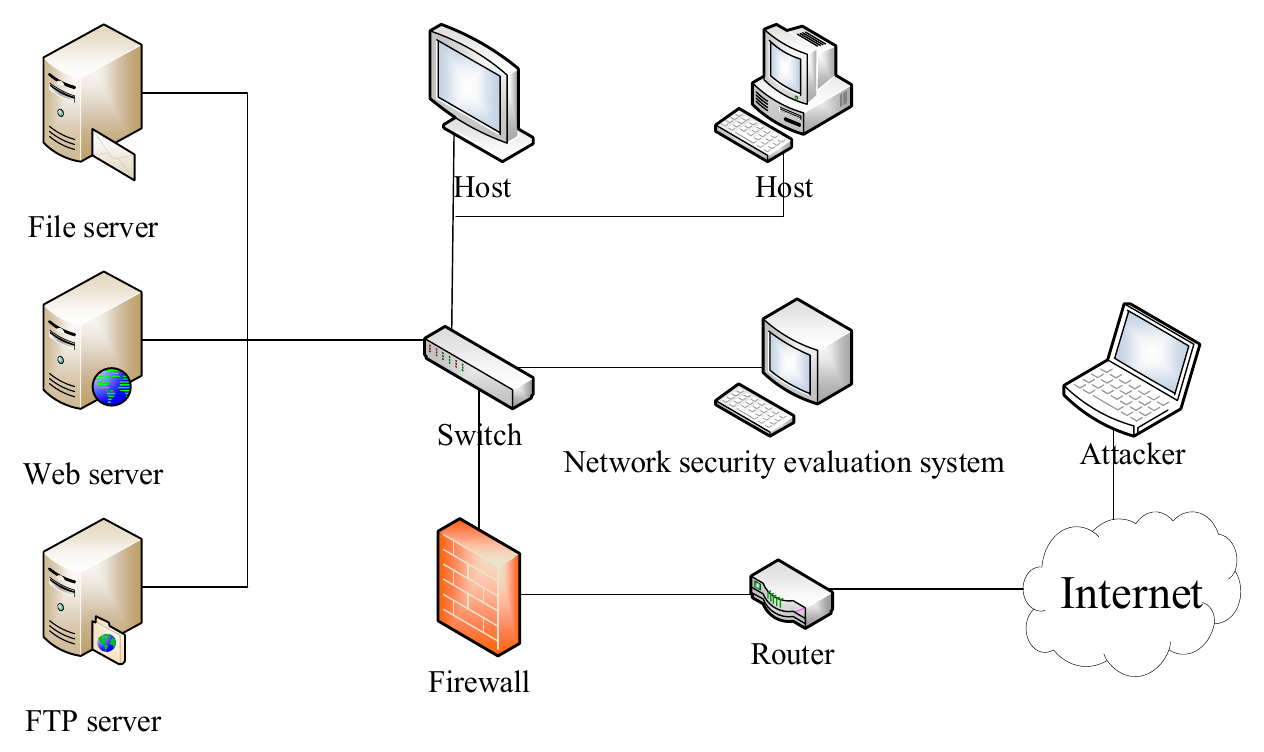
Figure 5. Network experiment environment diagram.